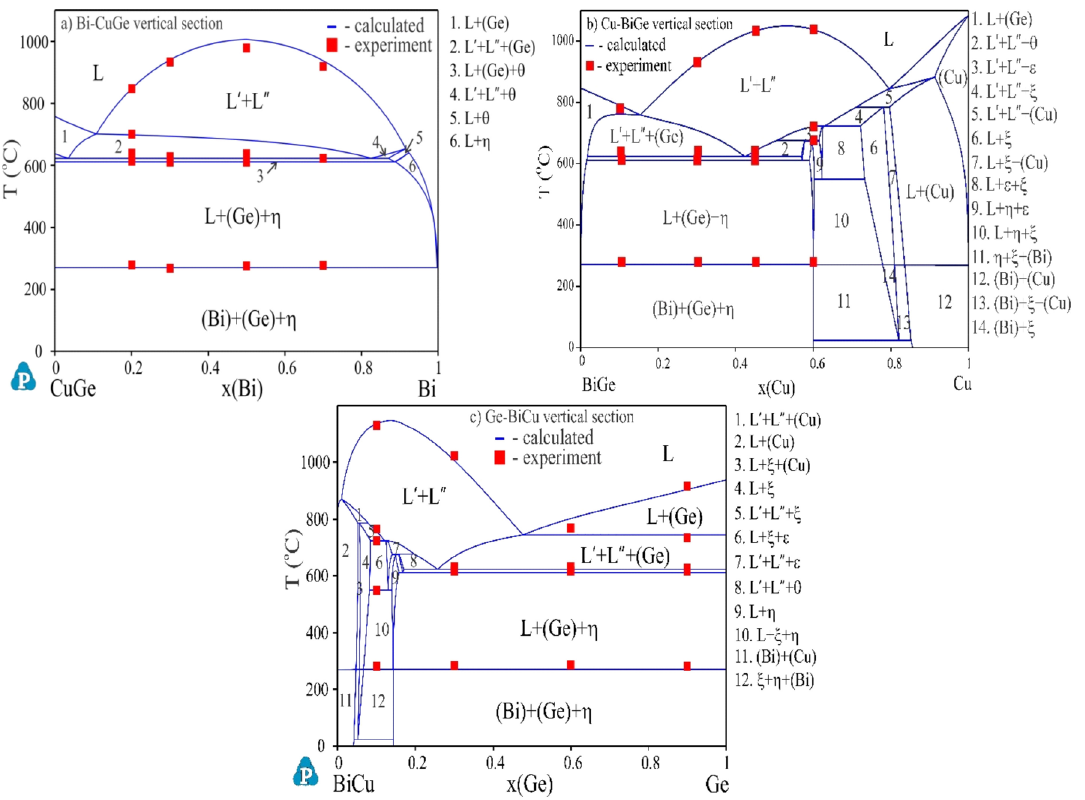
Figure 9. Calculated vertical sections of the ternary Bi-Cu-Ge system compared with DTA experimental results: a) Bi-CuGe, b) Cu-BiGe and c)